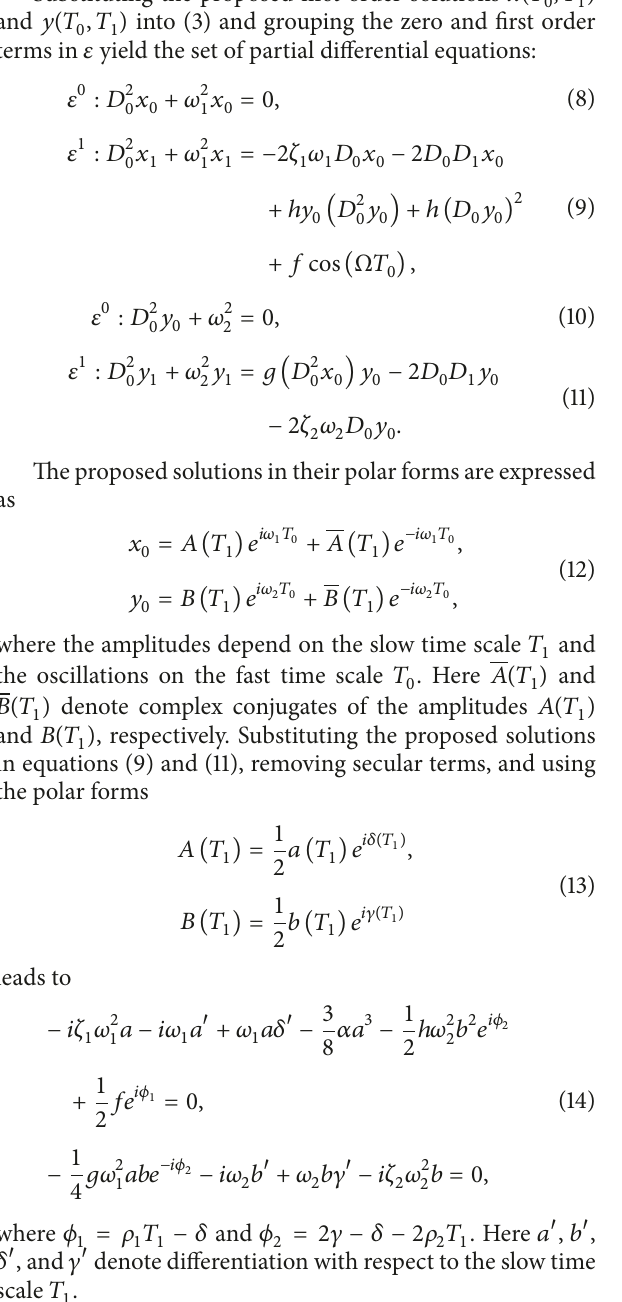
Table 1: Simulation system parameters.